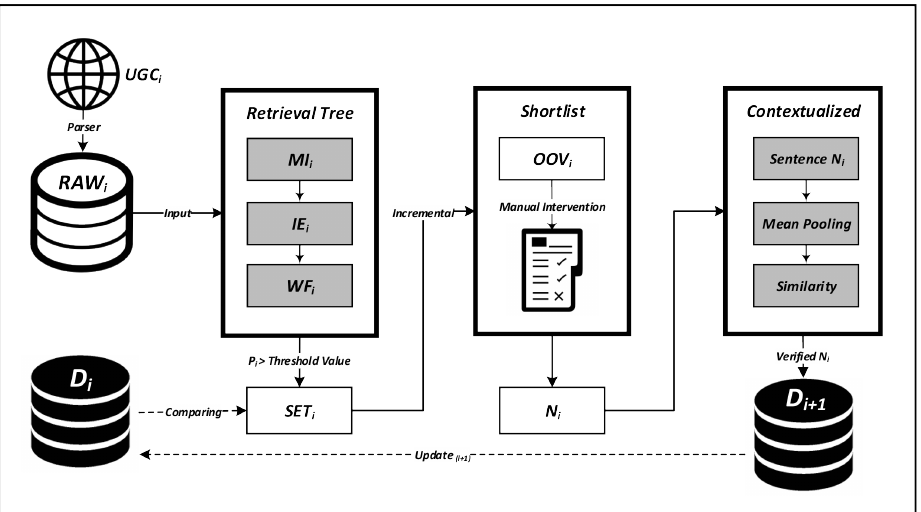
Figure 3. Semi-supervised algorithm